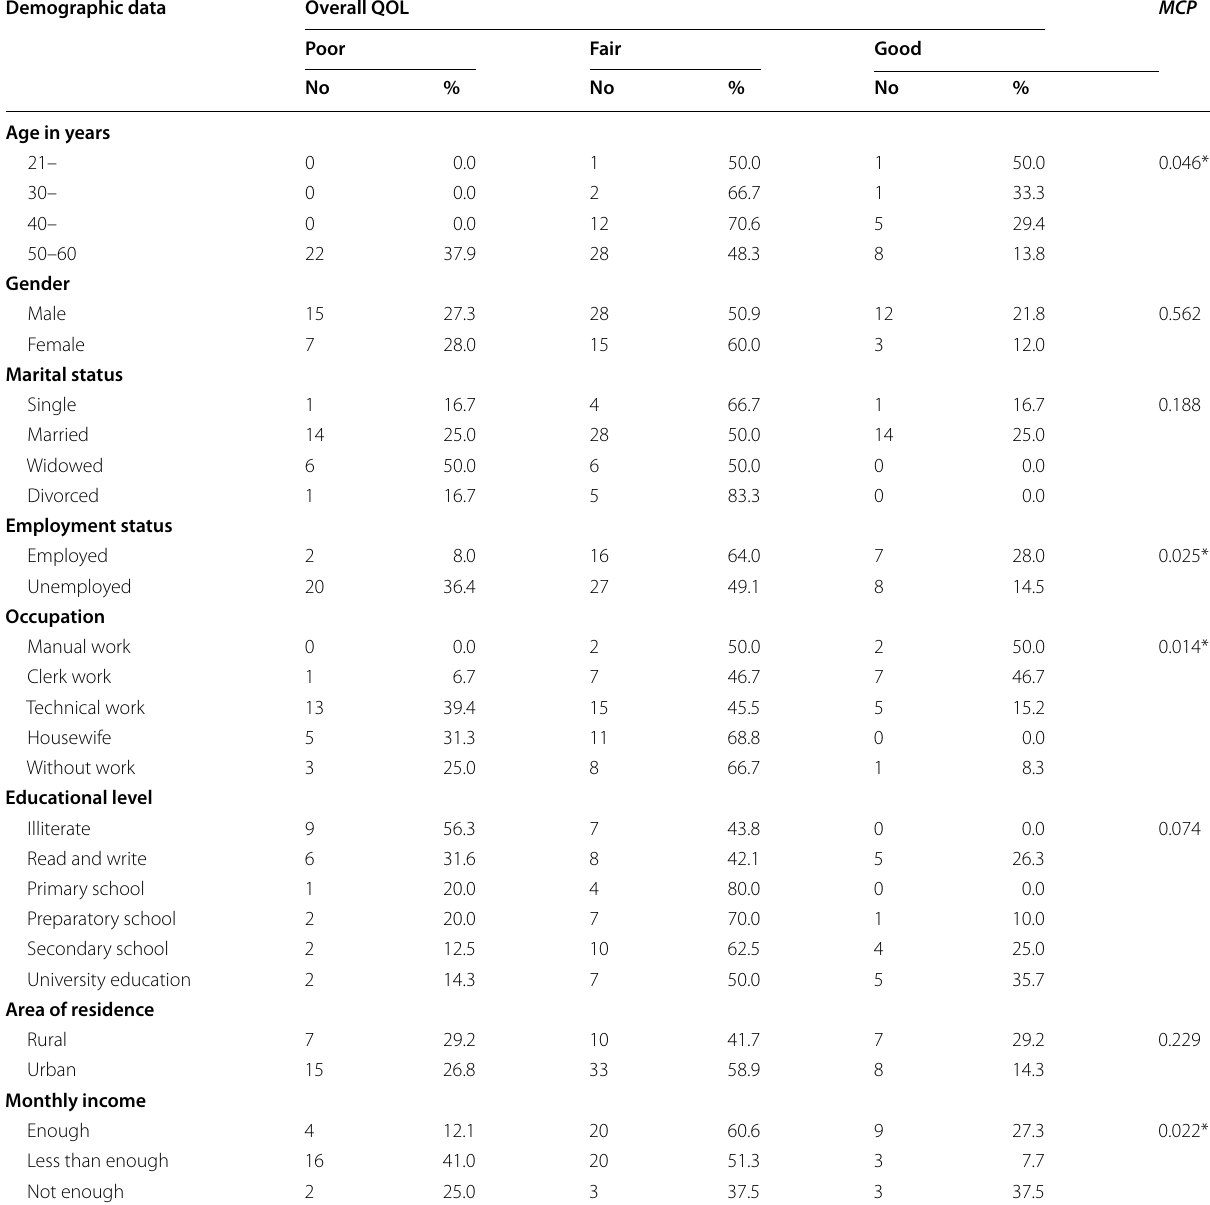
MCP Monte Carlo exact probability * P < 0.05 (significant)